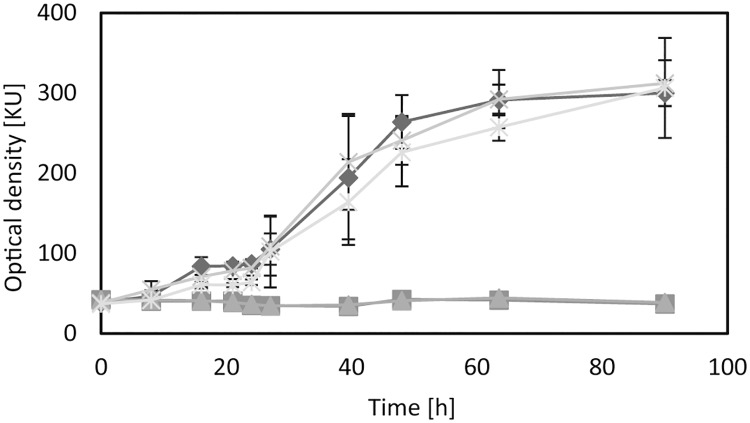
Utilization of Mercaptosuccinate (MS) by cells of A. mimigardefordensis strain DPN7T.: A. mimigardefordensis ΔlysR (MIM_c37410, squares), A. mimigardefordensis Δmsdo (MIM_c37420, triangles), A. mimigardefordensis Δ14530 (crosses), A. mimigardefordensis Δ37430–37480 (stars), A. mimigardefordensis strain DPN7T (diamonds).